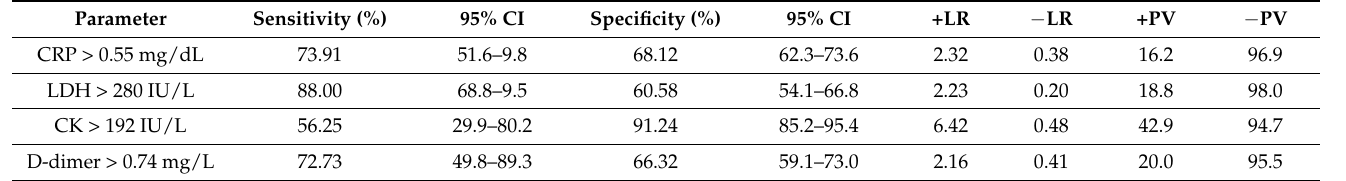
Table 4. The sensitivity and specificity of calculated cut-offs for selected biochemical parameters in the evaluation of the probability of oxygen therapy in the course of COVID-19 in